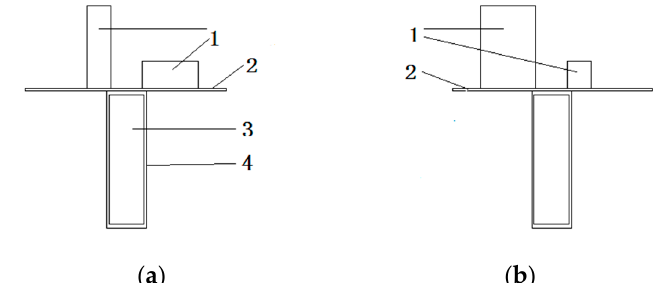
Figure 15. Cross-section for the axial field structure. 1-ferromagnetic rings, 2-axial air-gap, 3-axial field winding, 4-electrical insulation; ( a ) left section of the axial field structure; and, ( b ) right section of the axial field structure.